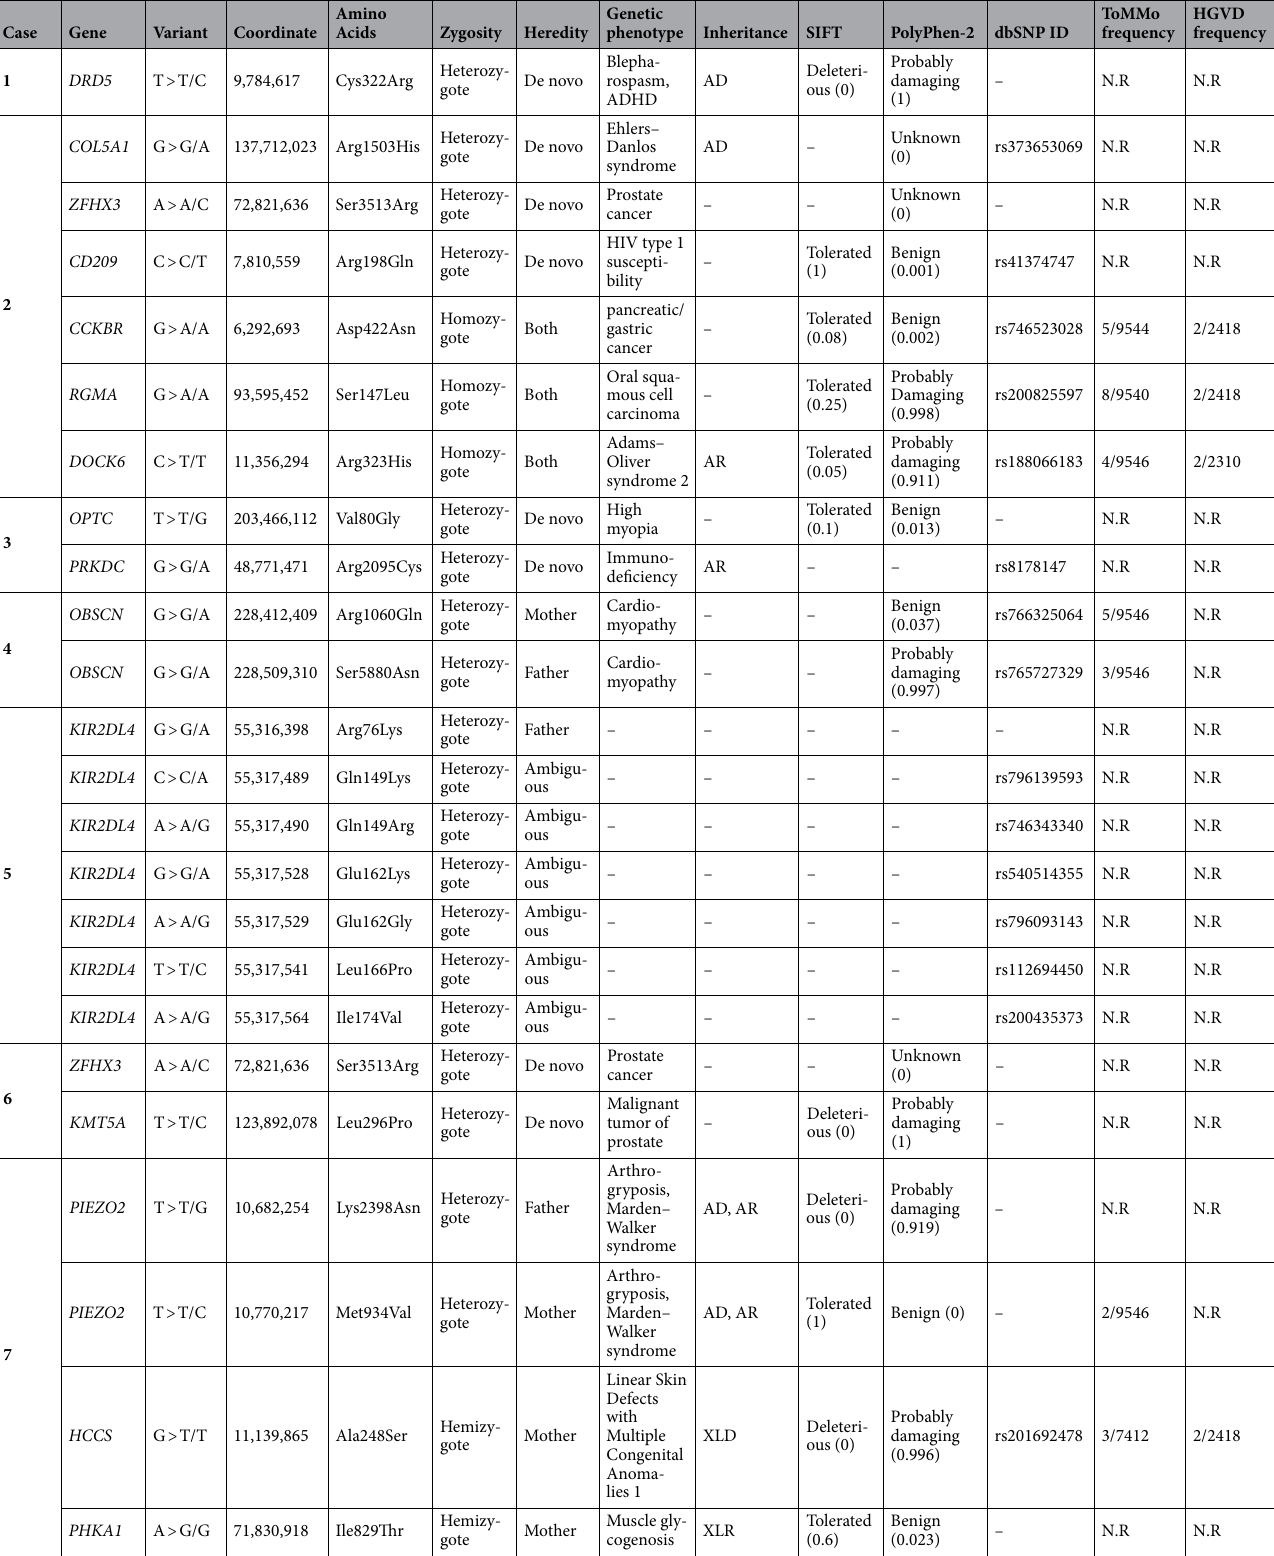
Table 4. Results of de novo, homozygous, compound heterozygous, and hemizygous variants. ADHD: attention-deficit hyperactivity disorder, HIV: human immunodeficiency virus, AD: autosomal dominant, AR: autosomal recessive, XLD: X-linked dominant, XLR: X-linked recessive, N.R.: not